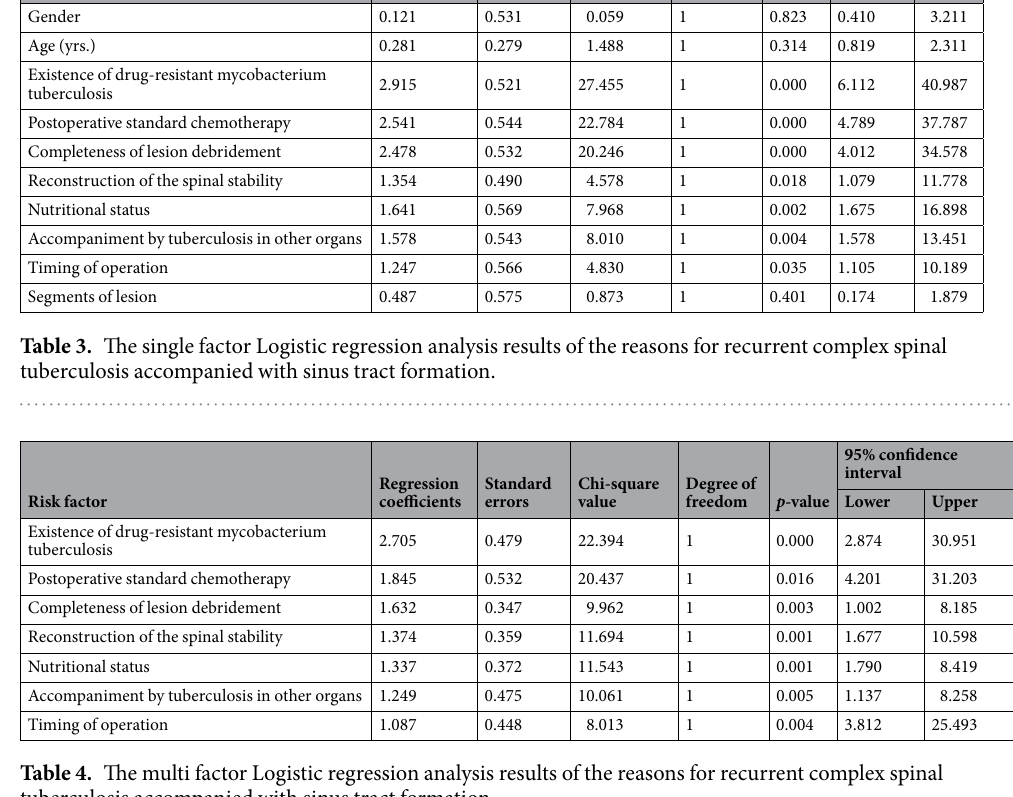
Table 4. The multi factor Logistic regression analysis results of the reasons for recurrent complex spinal tuberculosis accompanied with sinus tract